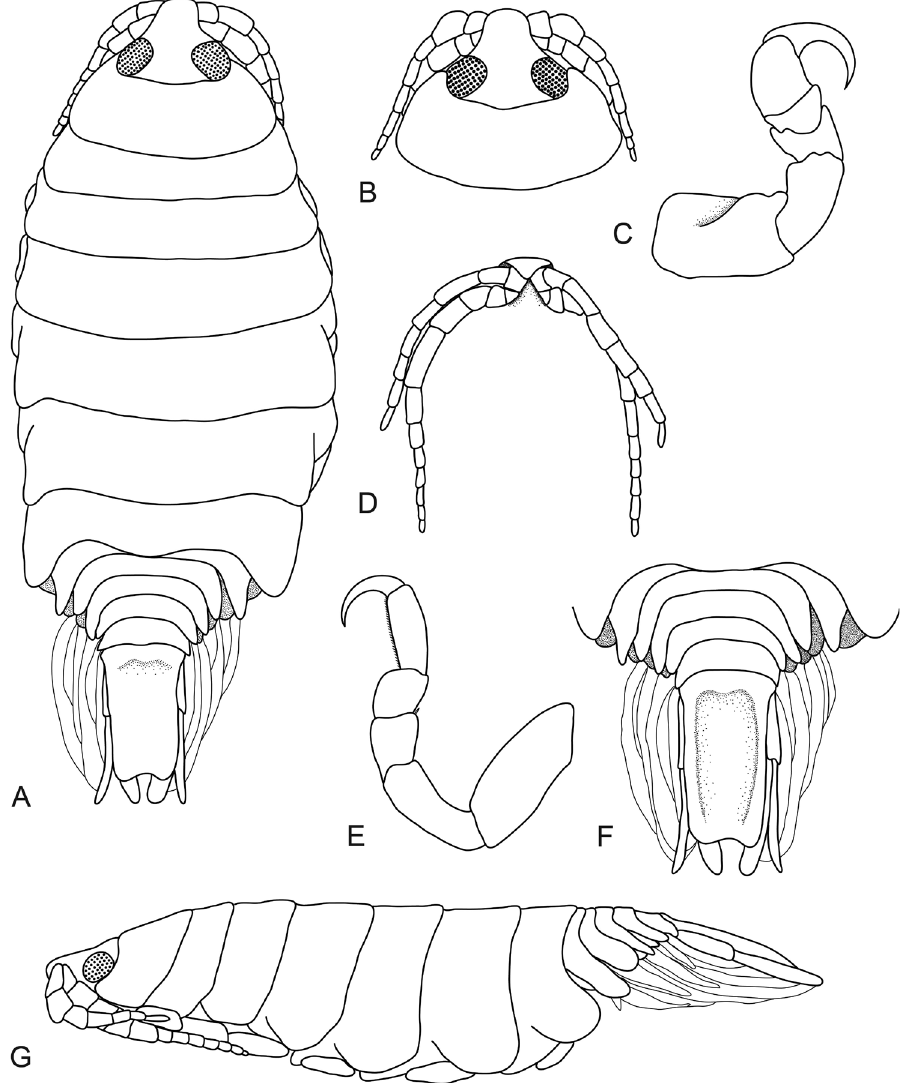
Figure 1. Pleopodias diaphus Avdeev, 1975 (USNM 231069), female (26 mm), (originally designated as the holotype of Pleopodias superatus Williams & Williams, 1986). A dorsal view B dorsal view of pere- onite 1 and cephalon C pereopod 1 D ventral view of cephalon E pereopod 7 F dorsal view of pleon and pleotelson G lateral